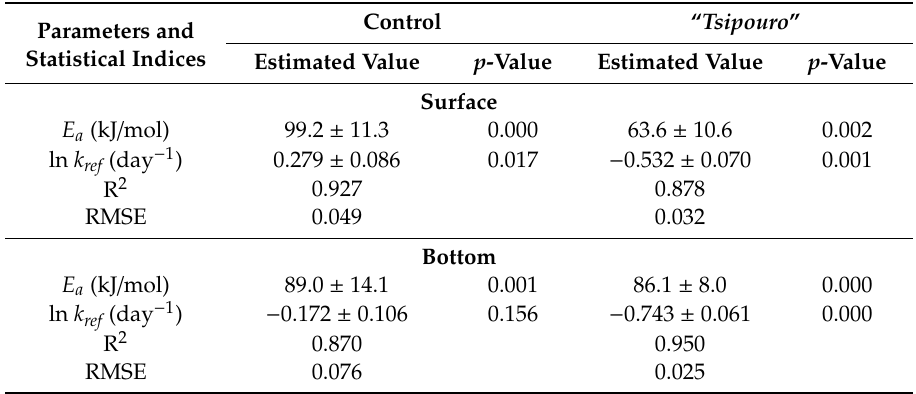
Table 4. Estimated parameters and statistics of the developed secondary Arrhenius models of a * value on the surface and bottom side of ground beef (500 g) packaged with absorbent pads supplemented with 50 mL of “ tsipouro ” (40 mL under the ground beef piece and 10 mL under the labelling, facing the headspace) and stored at 0, 4, 8, and 12 ◦ C under 80% O 2 : 20% CO 2 . Untreated samples served as